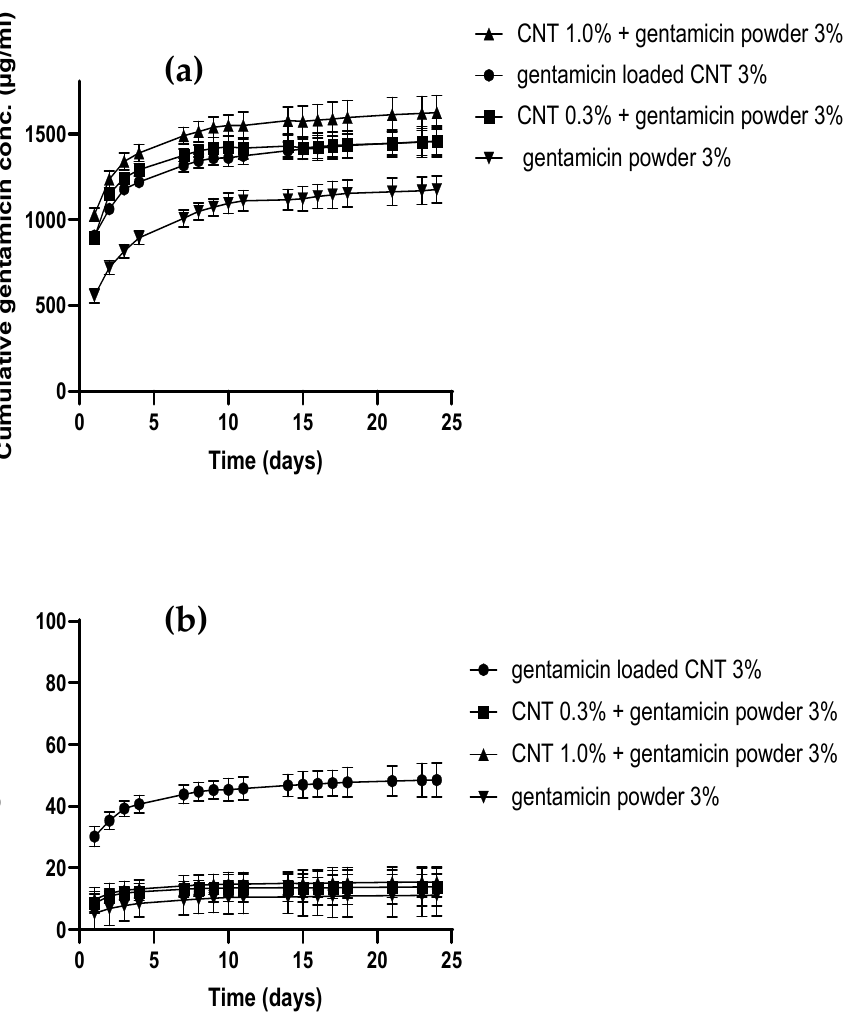
Figure 5. Gentamicin cumulative release profiles from different types of cement as concentration ( a ) and percentage ( b ) ( n = 3 ± SD).